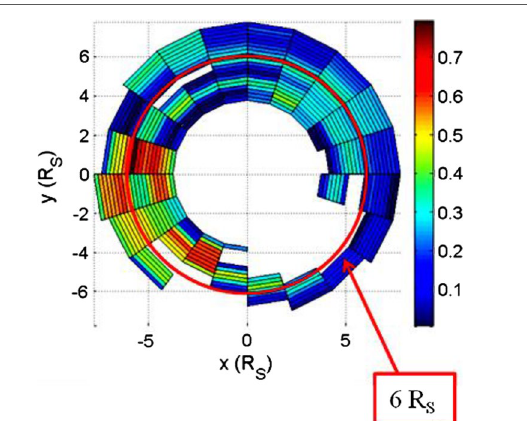
Fig. 11 The projection of the ICW δB amplitude distribution in the equatorial plane in a rectangular X – Y coordinate system, with the wave amplitude averaged over small areas of Δ R Δ φ 15° in a cylindrical coordinate system. The data were selected = between 1° latitude to avoid the latitudinal ±